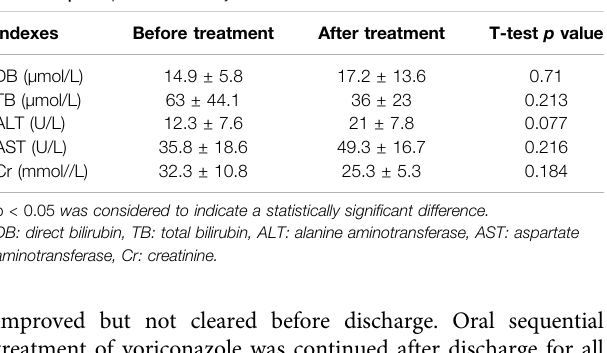
TABLE 4 | Comparison of safety indexes before and after voriconazole